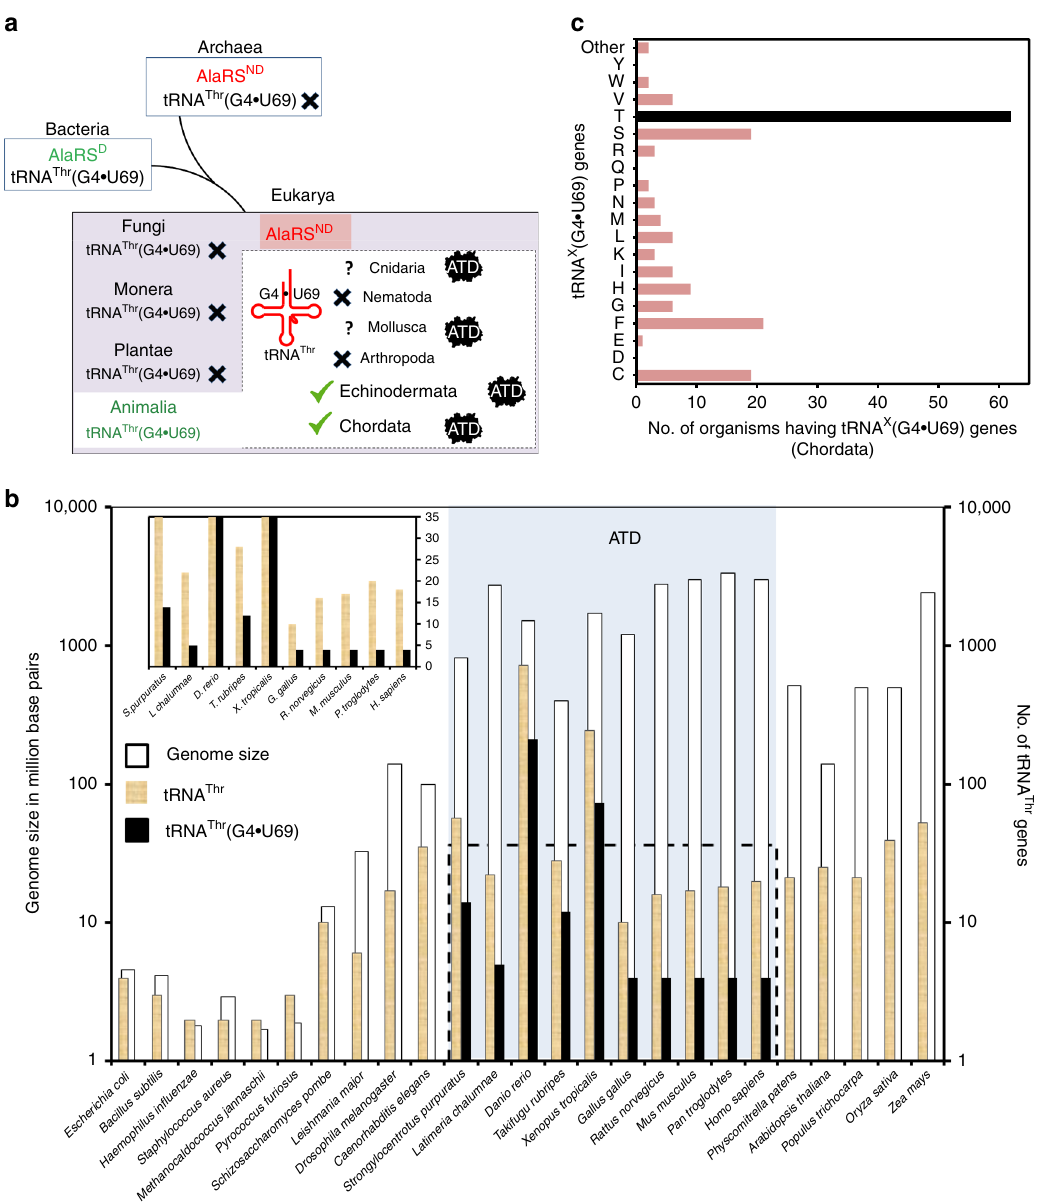
Fig. 7 Enrichment of tRNA Thr (G4 (cid:129) U69) genes and presence of ATD show strict association. a Distribution of AlaRS ND , tRNA Thr (G4 (cid:129) U69) genes, and ATD in different domains of life. tRNA gene sequences of Cnidaria and Mollusca are not available in the database. b Bar graph (logarithmic scale) depicting genome size, total number of tRNA Thr genes, and number of tRNA Thr (G4 (cid:129) U69) genes occurring in representative organisms belonging to all the three domains of life. Inset showing the number of total tRNA Thr genes and tRNA Thr (G4 (cid:129) U69) genes in normal scale; genome size has not been shown for the sake of clarity. Presence of ATD is highlighted in light blue box. Data for occurrence of AlaRS ND and tRNA Thr (G4 (cid:129) U69) genes have been taken from reference 53 . c Bar graph showing the number of organisms containing (G4 (cid:129) U69)-harboring tRNA genes which code for tRNAs speci fi c for various proteinogenic amino